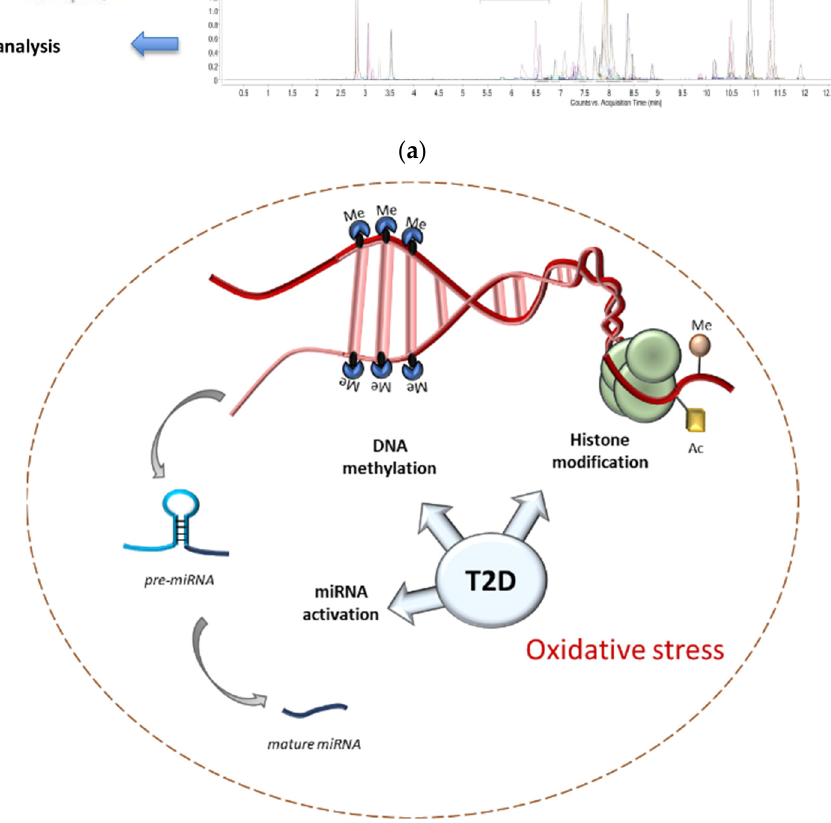
Figure 1. ( a ) Metabolites and lipids are extracted from tissues or biological fluids by several procedures (i.e., filch method, deproteinization) and injected into mass spectrometry instruments. Subsequently, the analysis of the chromatography acquired by the instruments leads to the identification and quantification of metabolites and lipids. Statistical analysis provides the significant changes regarding the detected metabolites/lipids. ( b ) Representation of the main epigenetic mechanisms in patients with type 2 diabetes: (1) Histone modification (in the example, acetylation and methylation), (2) DNA methylation, and (3) microRNA activation for post-transcriptional regulation. In DNA methylation, a methyl group is covalently added to the carbon-5 position in the CpG dinucleotide sequence and represses gene activity by preventing the binding of